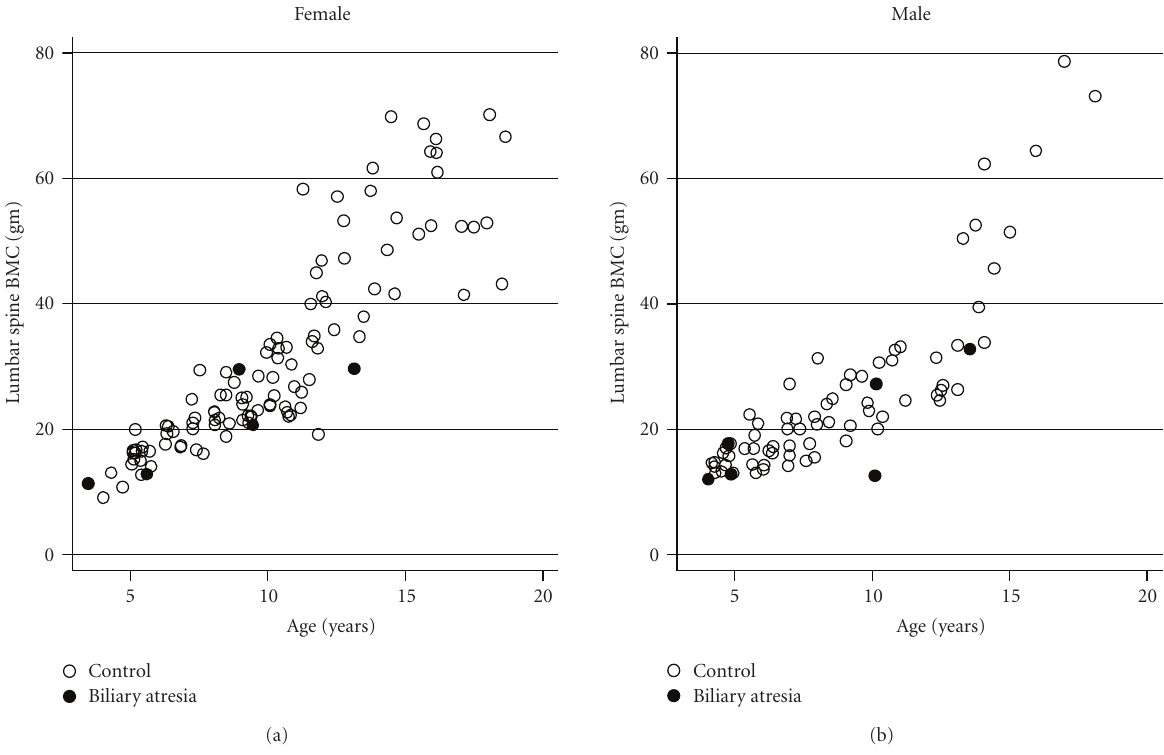
Figure 2: Age versus lumber spine bone mineral content in BA subjects compared to